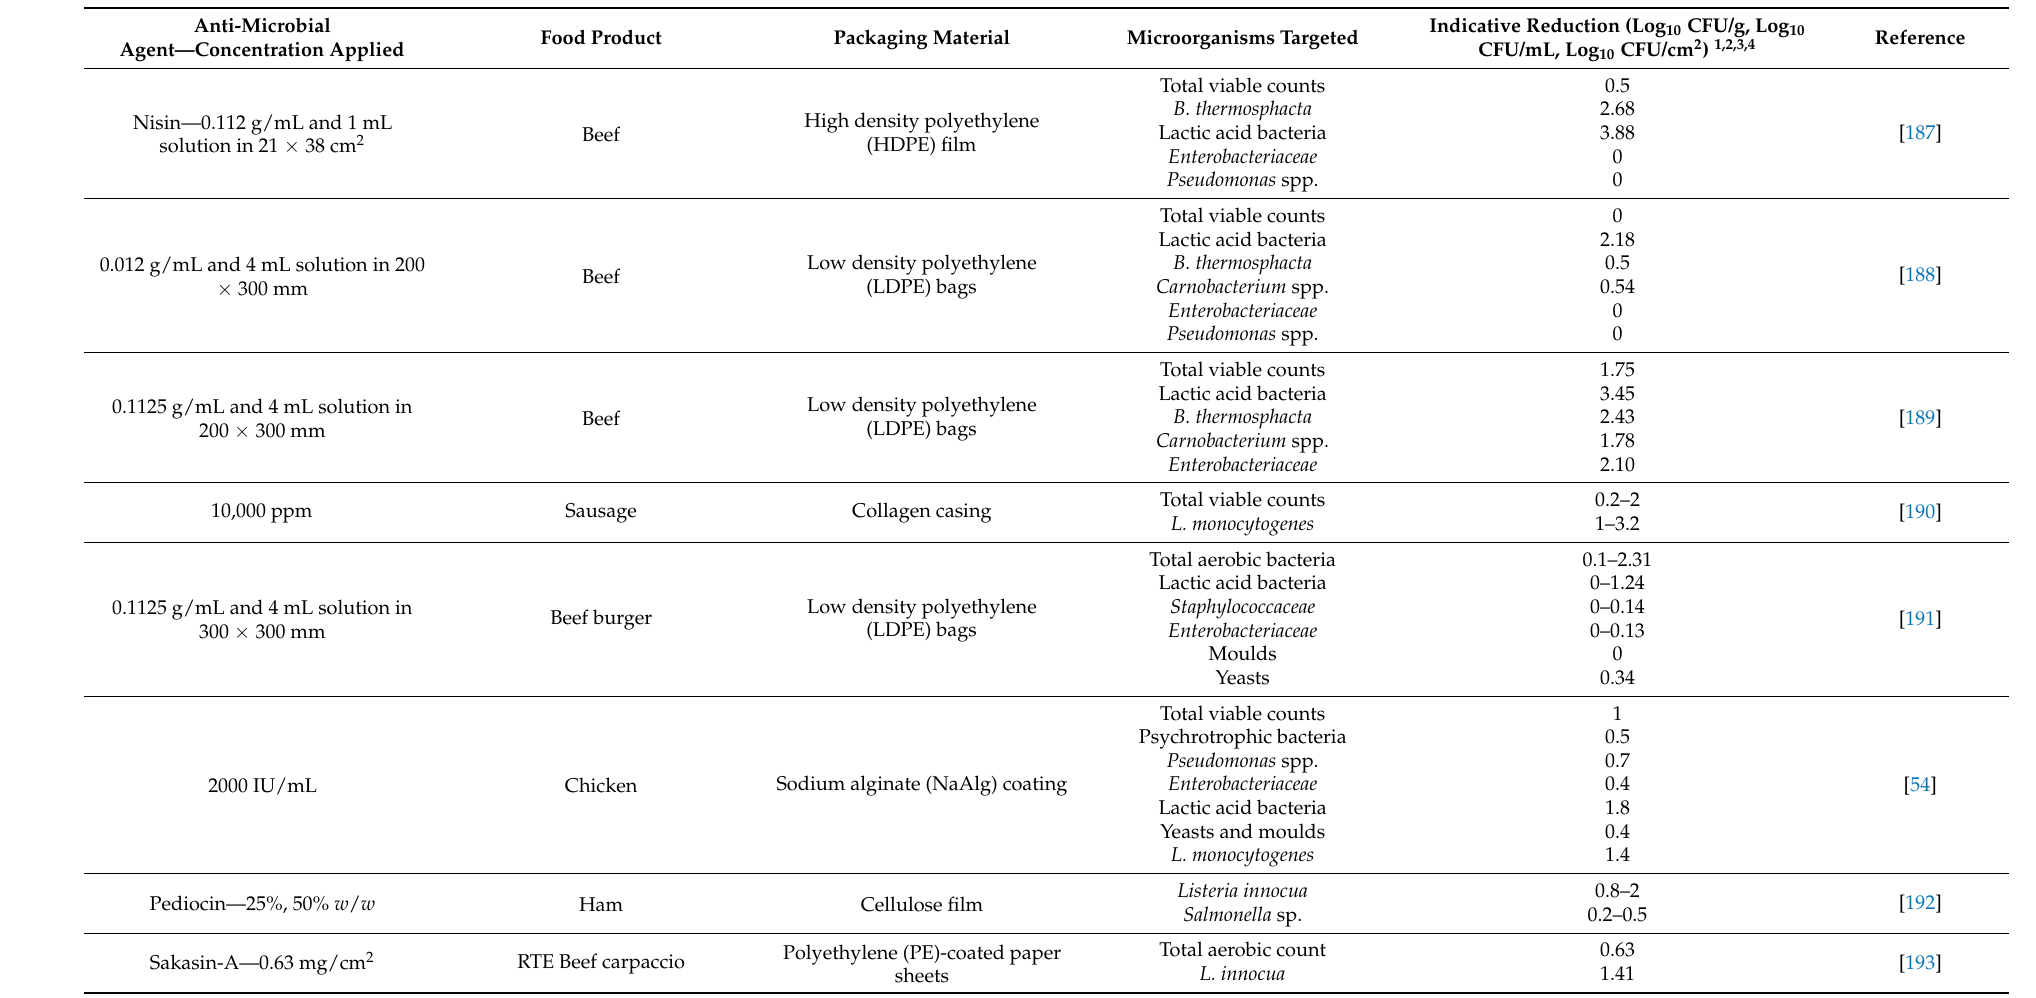
Table 4. Overview of studies testing the efficacy of anti-microbial packaging with bacteriocins on meat products. Anti-Microbial Agent—Concentration